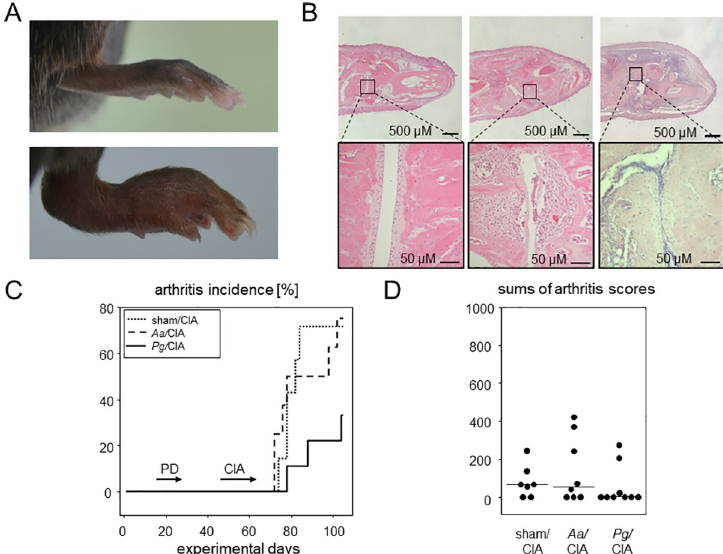
Fig 4. PD did not impact on subsequent CIA. CIA led to macroscopically visible swelling of the paws and microscopic deterioration of the joints (A) A swollen hind paw resulting from CIA (lower panel) in comparison to the paw of a control (sham/noCIA) mouse (upper panel). (B) HE stained thin sections of hind paws reveal inflammatory infiltrates in Aa /CIA and Pg /CIA compared to a control specimen from sham/noCIA animals. (C) Inverted Kaplan- Meier curves show arthritis incidences over time. Horizontal arrows indicate periods of disease inductions. Numbers are n = 7 for sham/CIA, n = 8 for Aa /CIA and n = 9 for Pg /CIA. (D) Dot plots summarize the sums of macroscopic arthritis scores at endpoint, assessed every other day starting from boost. Every dot represents a single mouse. CIA: collagen induced arthritis; PD: periodontal disease.